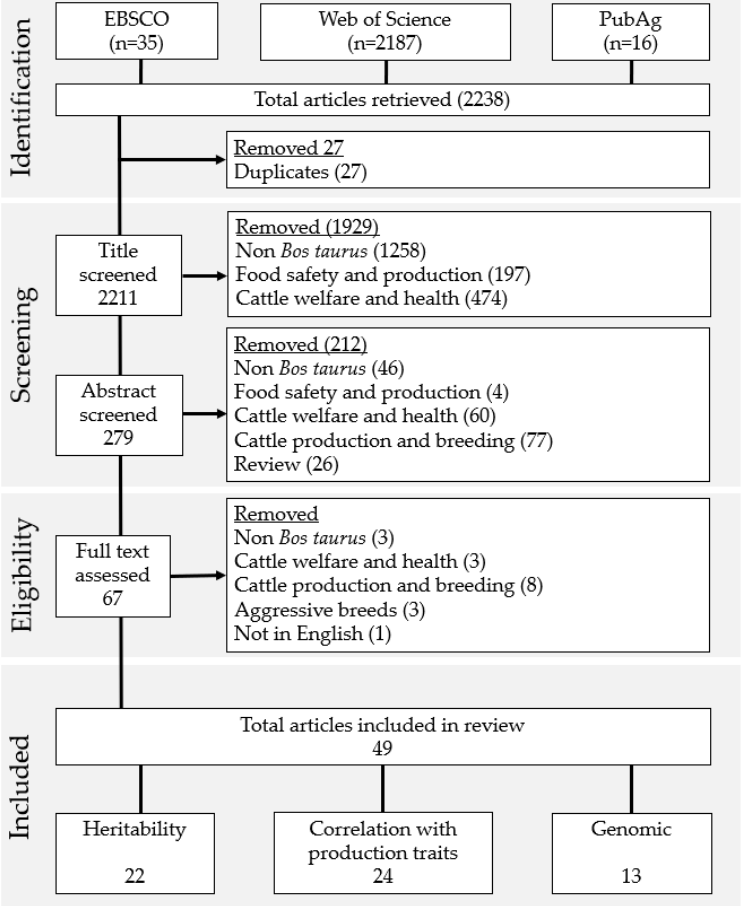
Figure 1. Selection process of studies returned through search protocol using PRISMA Framework [13] (Please note that the included categories were non-exclusive and the same study may have been included in multiple categories).